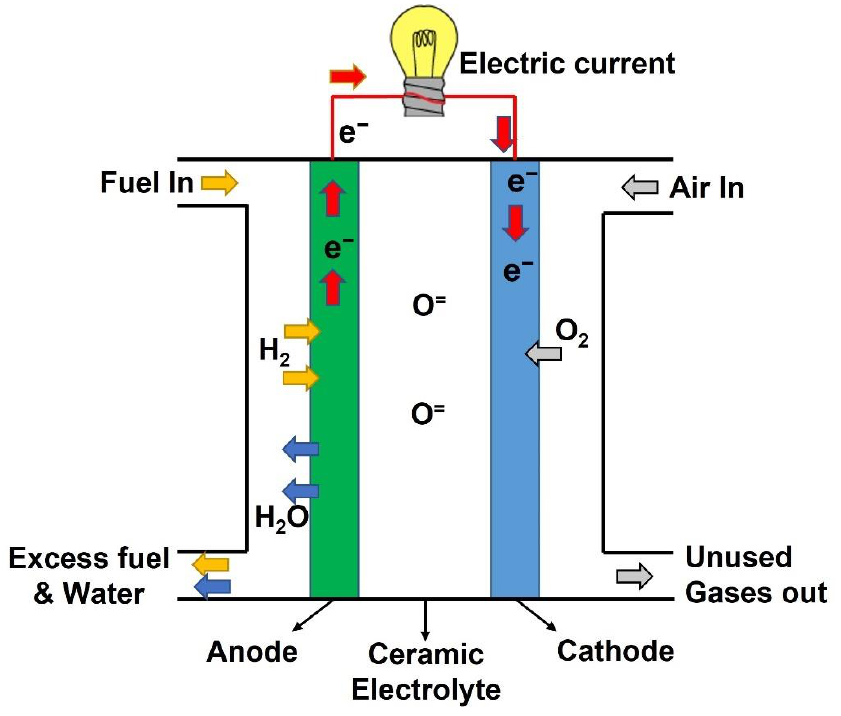
Figure 2. Basic schematic diagram of a SOFC.